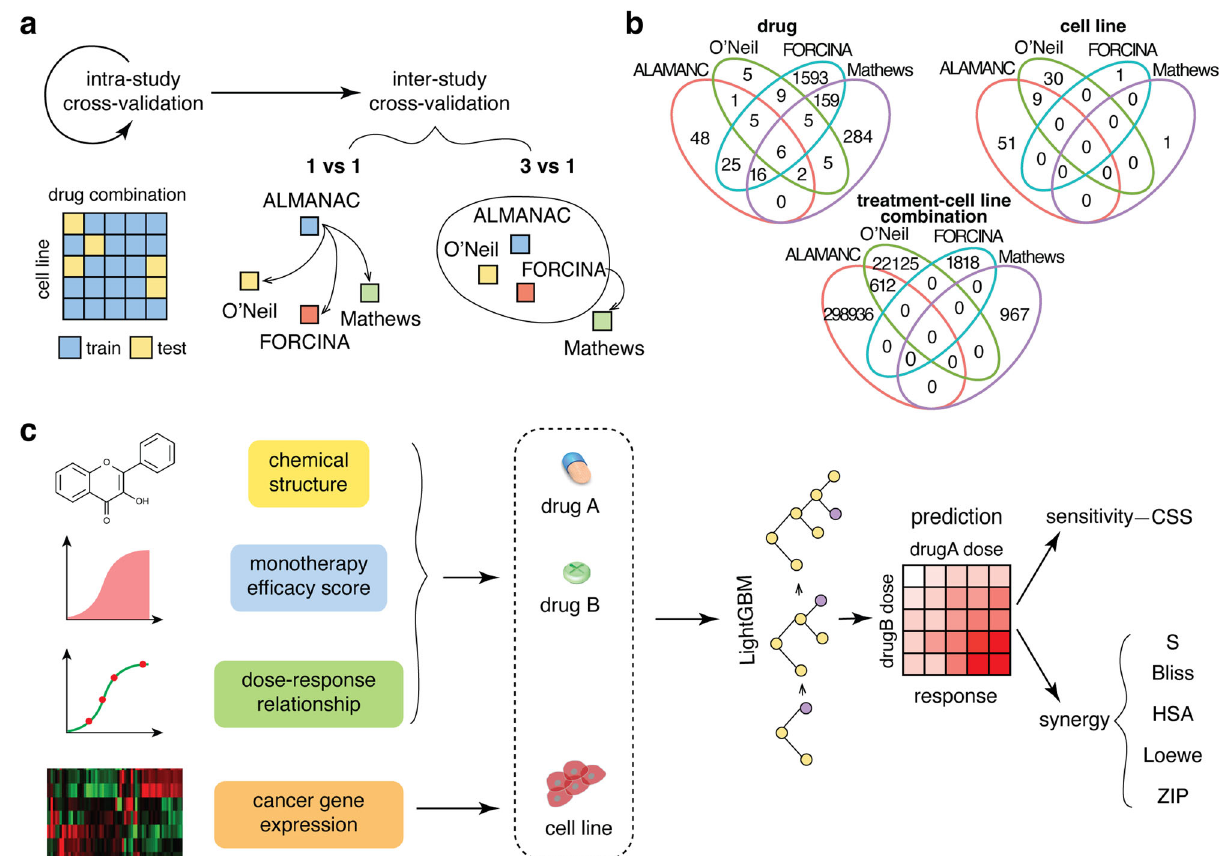
Fig. 1 Overview of the framework on intra- and inter-study drug combination predictions. a The cross-validation strategy. We carry out the cross- validation in two steps: intra-study, which is fi ve-fold cross-validation carried out within a single dataset, where the training and test sets are split by drug combination and cell lines, and inter-study, which is carried out between different datasets. The models used in the 1 vs. 1 inter-study cross-validations are the models generated from the inter-study training step. For the 3 vs. 1 inter-study cross-validation, three of the four datasets are combined and used as the training set to generate fi ve models by fi ve-fold cross-validation and then tested on the remaining dataset. b The overlapped information (drug, cell line, and treatment-cell line combination) between the four datasets used in this study. c The schematic of model construction in this study. We use four different data sources to generate the machine learning model used in this study. For drug-related features, we used chemical structure, monotherapy ef fi cacy score, and their corresponding dose – response relationship. For the treated cancer cell lines, we used the transcription levels of 293 cancer-related genes. The constructed features are input into a lightGBM learner to generate models predicting the six different response metrics of the combination treatment: CSS, which is the sensitivity score representing the ef fi cacy of the combination, and fi ve synergy scores (S, Bliss, HSA, Loewe, and ZIP) representing the degree of interaction between the two